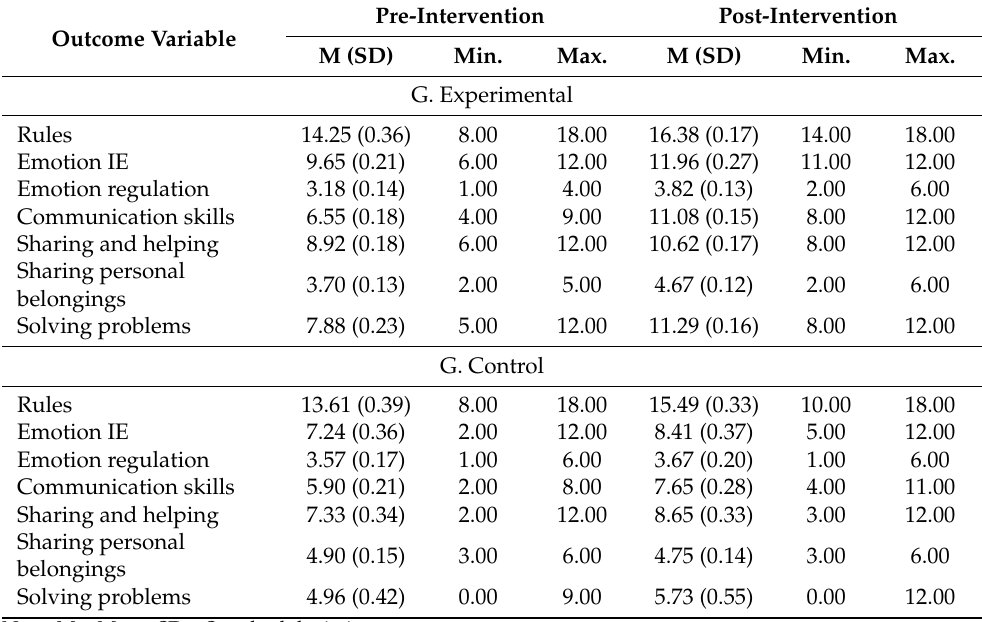
Table 1. Descriptive measures related to the variables used in AC1 program by groups and phases. Pre-Intervention Post-Intervention Outcome Variable M (SD) Min. Max. M (SD) Min.